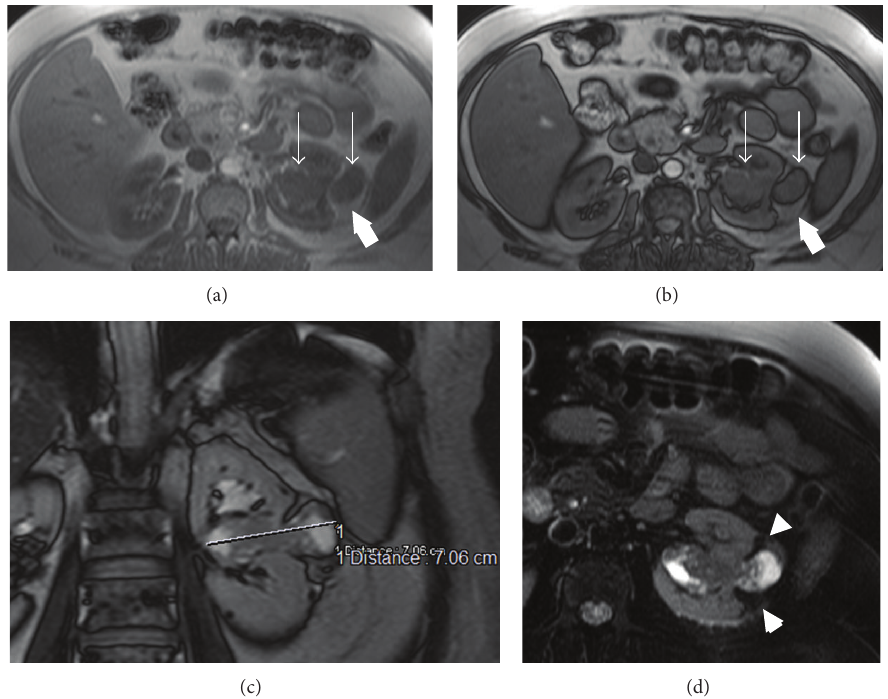
Figure 1: (a–d) E-AML both contains fatty and nonadipose components. T1W axial in-phase (a) and out-phase images (b) reveal mass lesion involving renal sinus and subcapsular region. No apparent fat is seen in some portion (thin arrows). However, due to pure fat content of subcapsular tumor component, no signal reduction is seen in dual echo imaging (thick arrow). TruFISP coronal image (c) shows subcapsular extension and maximum diameter. Axial T2W fat-saturated image (d) shows solid infiltrative renal mass with renal sinus and pelvicalyceal extension; note that pure fatty portion of subcapsular component demonstrates signal reduction (arrowheads).